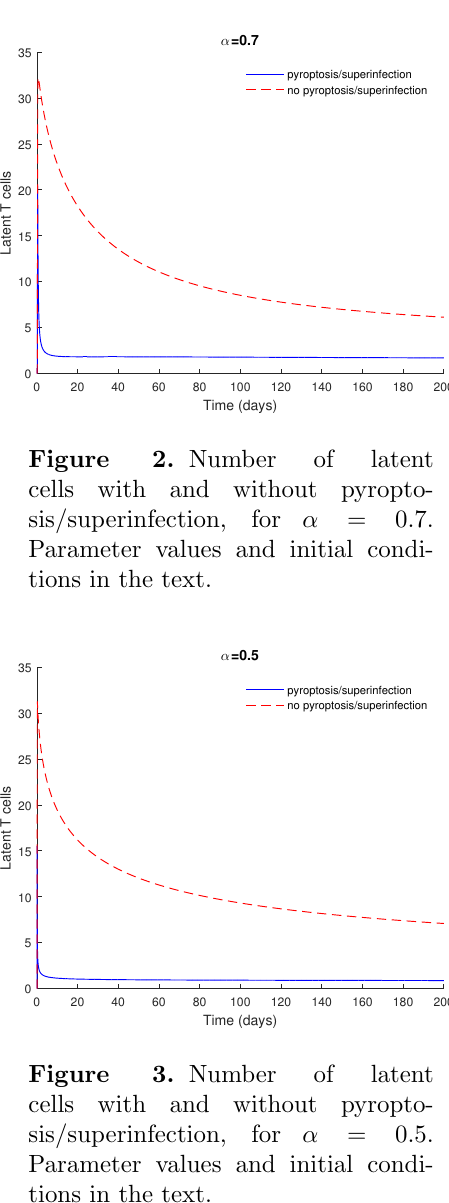
Figure 1. Number of latent cells with and without pyropto- sis/superinfection, for α = 1. Param- eter values and initial conditions in the text.